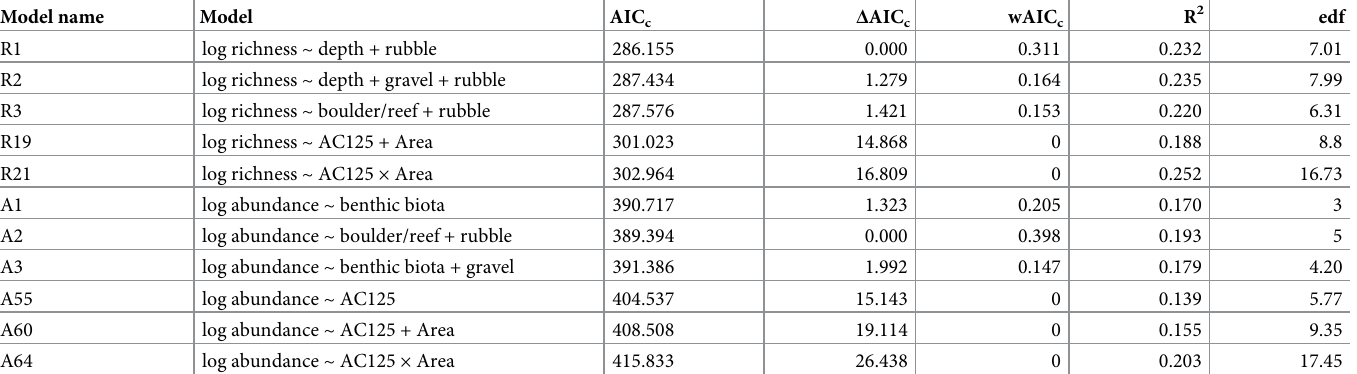
Table 4. Top three GAMM model fits and fits exclusively with AC125 and area, examining the effects of predictors on log transformed richness (R) and relative abundance (A, summed